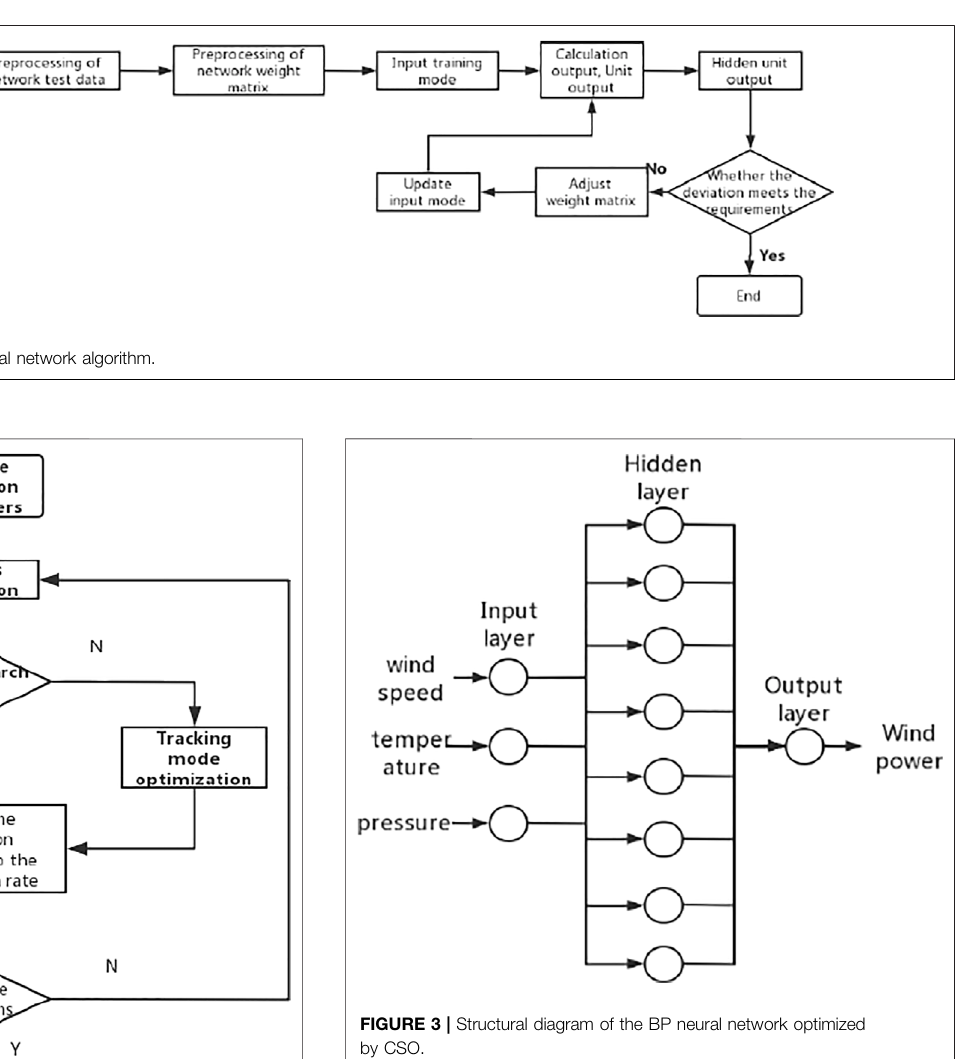
FIGURE 3 | Structural diagram of the BP neural network optimized by